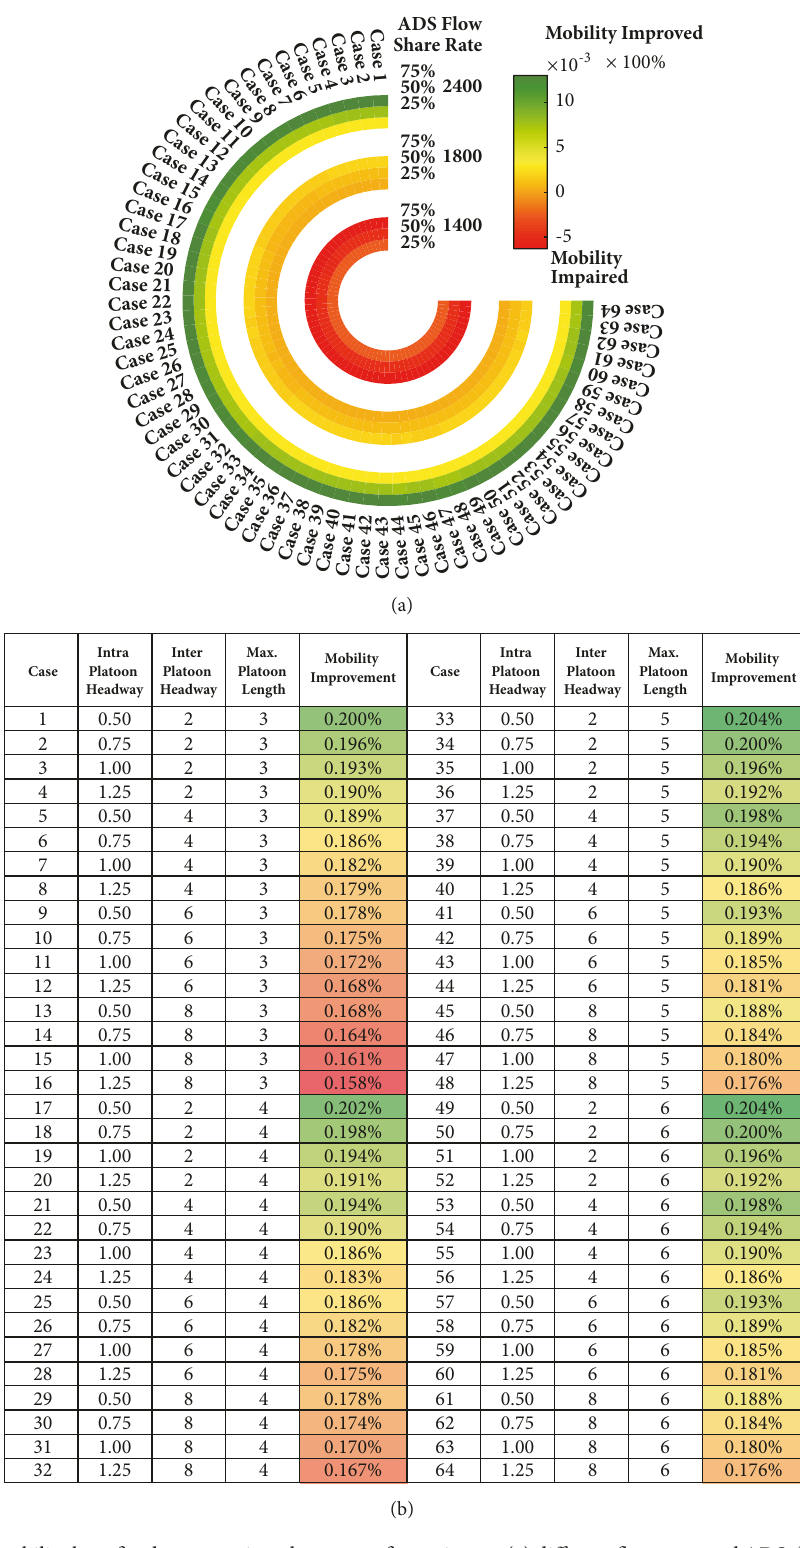
Figure 3: Variations of mobility benefits due to varying platoon configurations at (a) different flow rates and ADS shares and (b) specific flow rate (1800 veh/hr) and ADS share